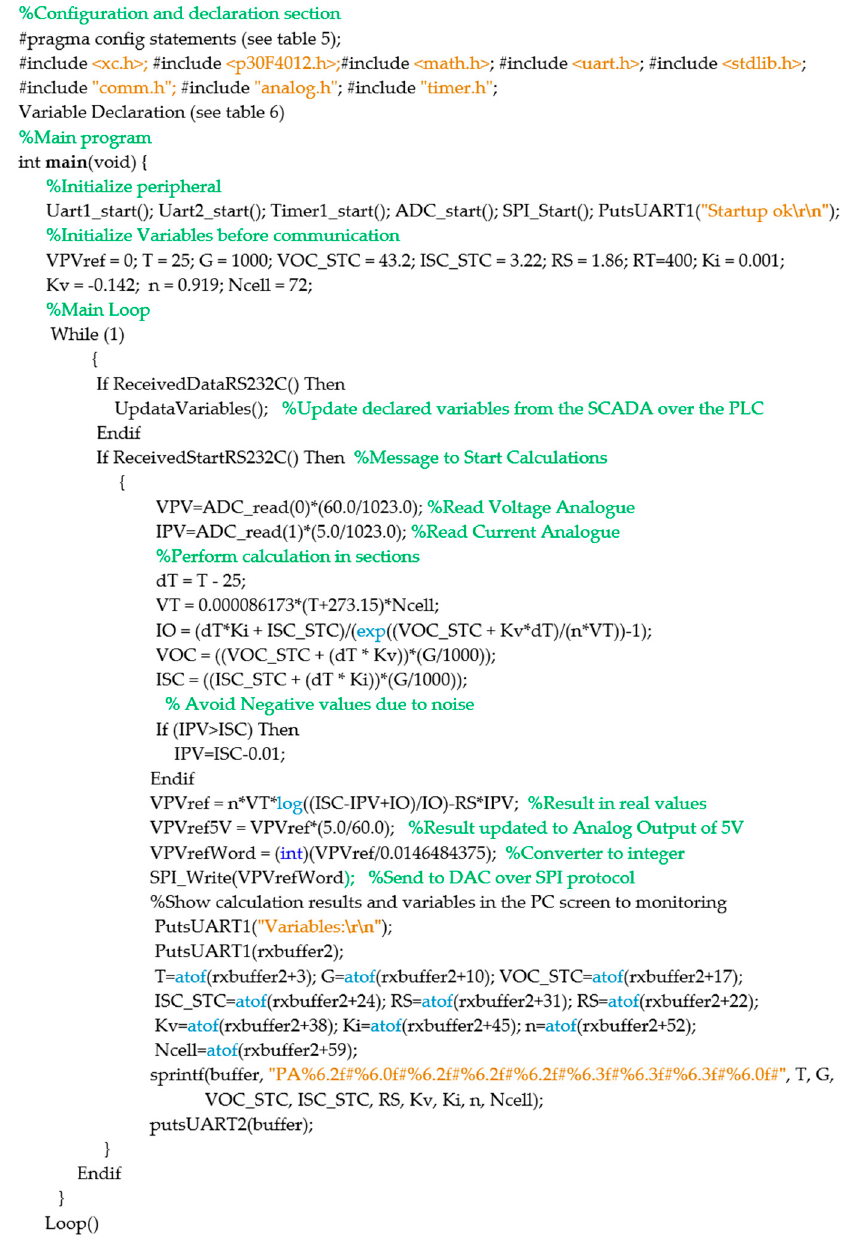
Figure 20. Simplified pseudocode of the DSP device programmed in C code.